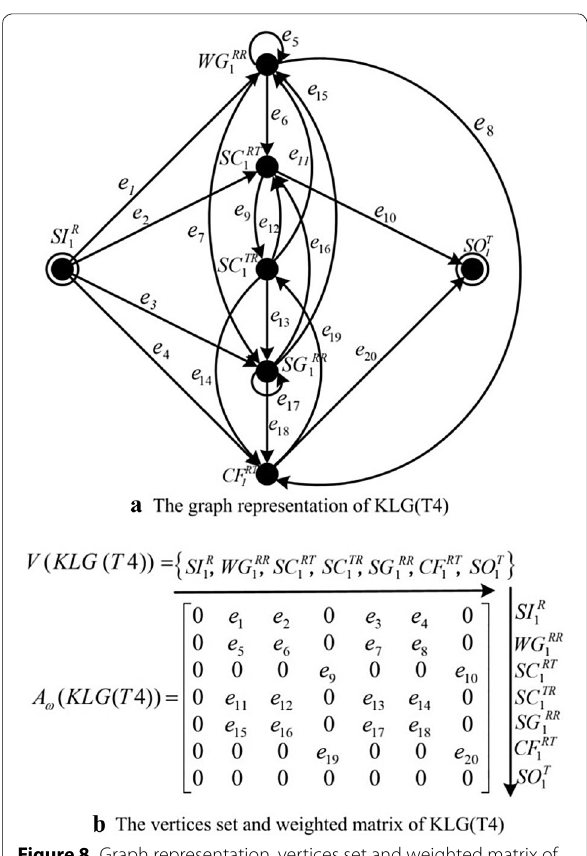
Figure 8 Graph representation, vertices set and weighted matrix of KLG ( T